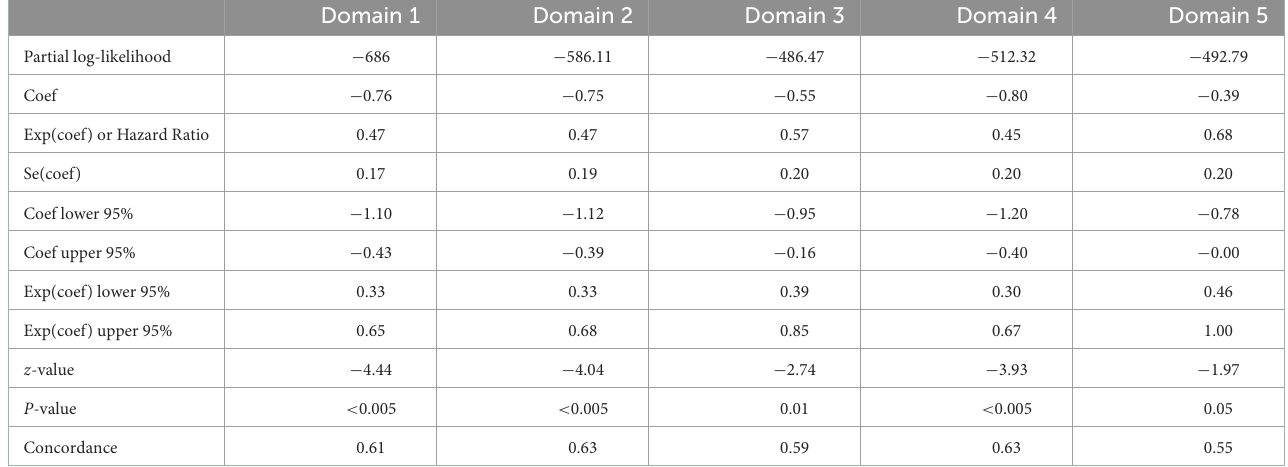
TABLE 6 Summary of Cox Proportional-Hazards Model on all